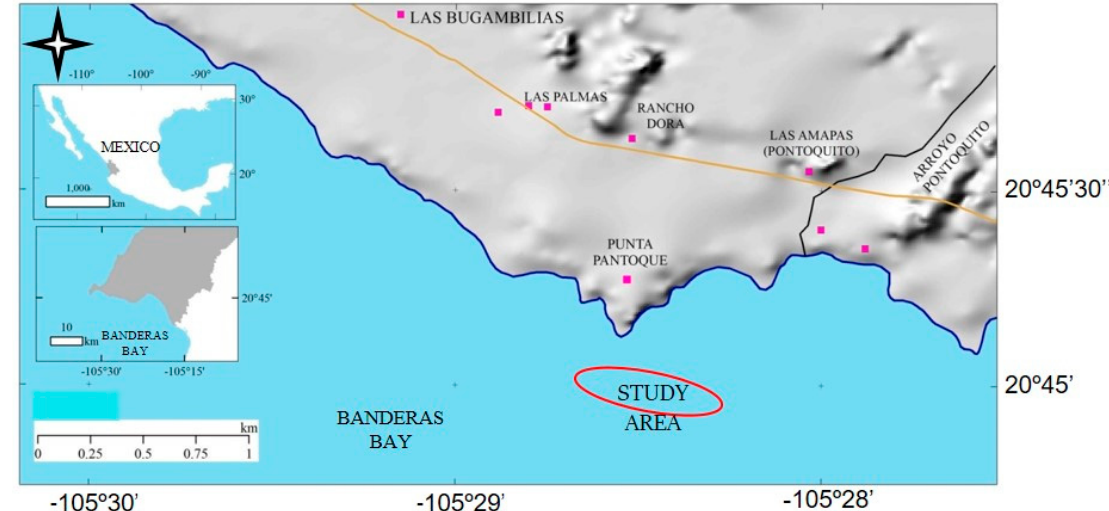
Figure 1. Study zone: location of the shallow hydrothermal vents at Punta Mita. The red oval indicates the study sites.